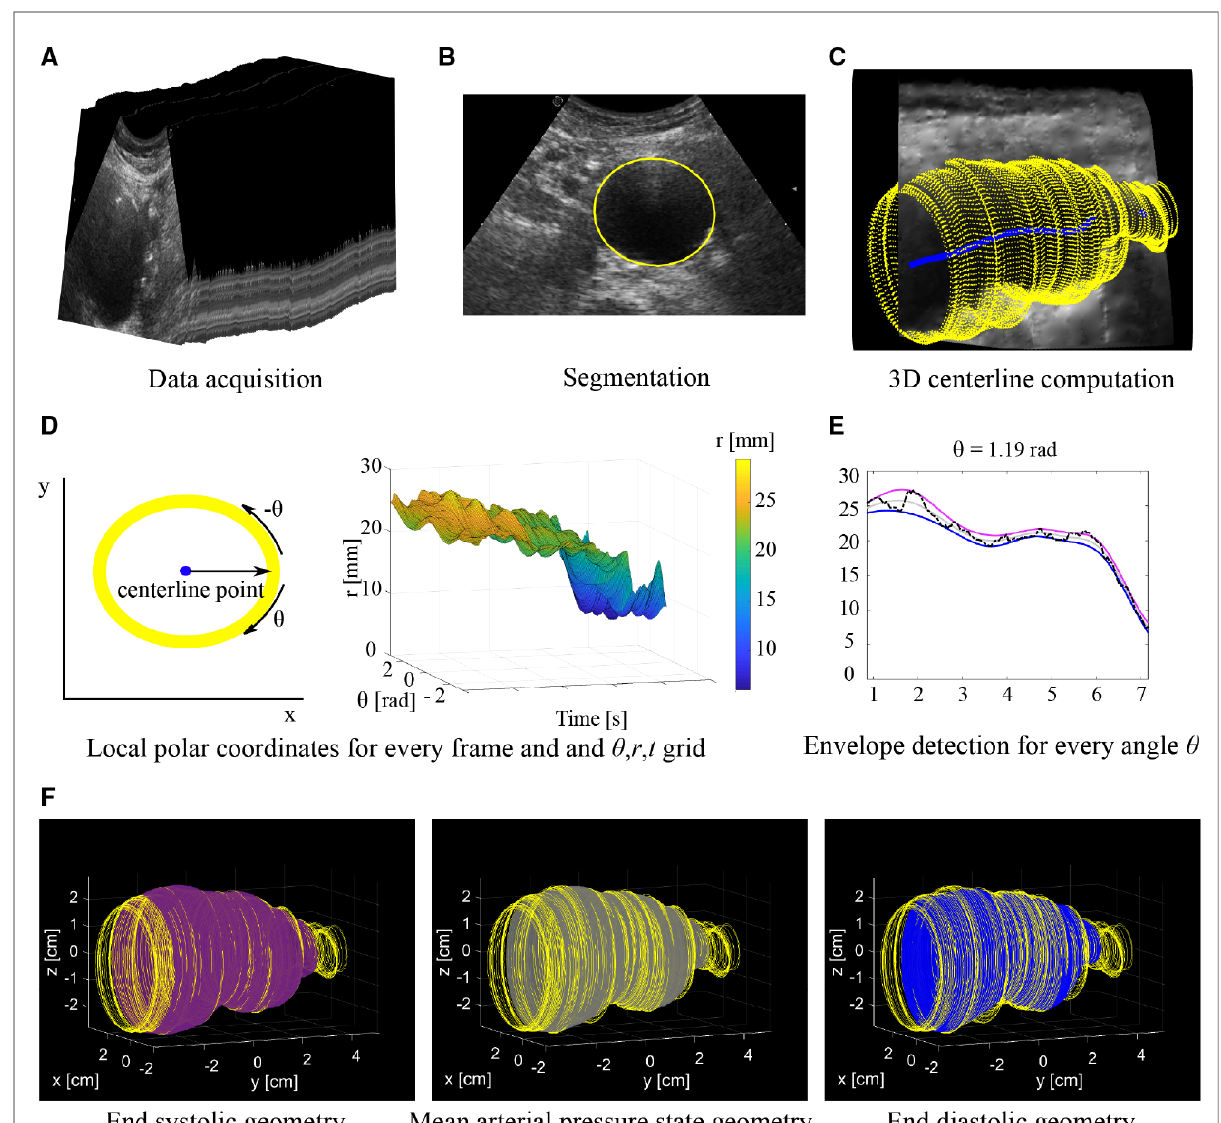
FIGURE 1 Overview of work fl ow. ( A ) Series of 2D US frames acquired with freehand 2D US imaging. ( B ) Segmentation is performed on the individual 2D US frames. ( C ) Contours segmented from each frame (yellow) are mapped into 3D space together with the 3D centerline (blue). ( D ) Conversion of coordinates of each frame to a local polar coordinate system centered around the center line and generating a θ , r , t grid. ( E ) Envelope detection on a radius time signal (black line) for a single angle θ . The radii at end diastole (blue line) and end systole (purple line) are estimated from which the radii at the mean arterial pressure state (grey line) are derived. ( F ) Final 3D geometries with from left to right: End systole (purple), mean arterial pressure state (grey) and end diastole (blue). Geometries are shown together with the original contours